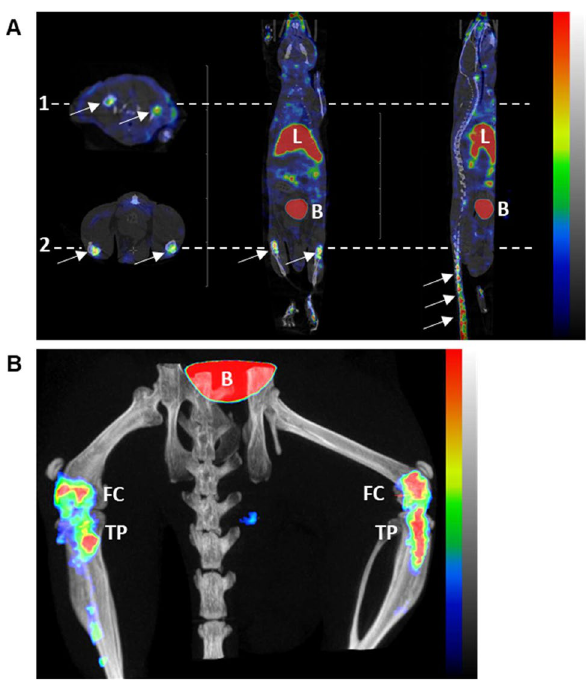
Figure 1. In vivo distribution by SPECT-CT imaging of 99m Tc-NTP 15-5 30 min after intravenous injection of 20 MBq of radiotracer in healthy mice. ( A ) Representative transversal, coronal, and sagittal slices of 99m Tc-NTP 15-5 distribution in anesthetized mice. From left to right: transversal views at the humeral head level (dotted line 1) and at the knees level (dotted line 2); coronal and sagittal whole-body views. Arrows indicate cartilage uptake in the mouse shoulders, knees, and intervertebral disks, respectively. Non-specific uptake is observed in the liver (L) and bladder (B). SPECT scaling range is 65 to 650 kBq/ml. ( B ) Representative SPECT-CT Maximum Intensity Projection 3D image focused on knees. Specific uptake in femoral condyle (FC) and tibial plateau (TP) is observed, as well as non-specific accumulation in bladder (B). SPECT scaling range is 650 to 2000